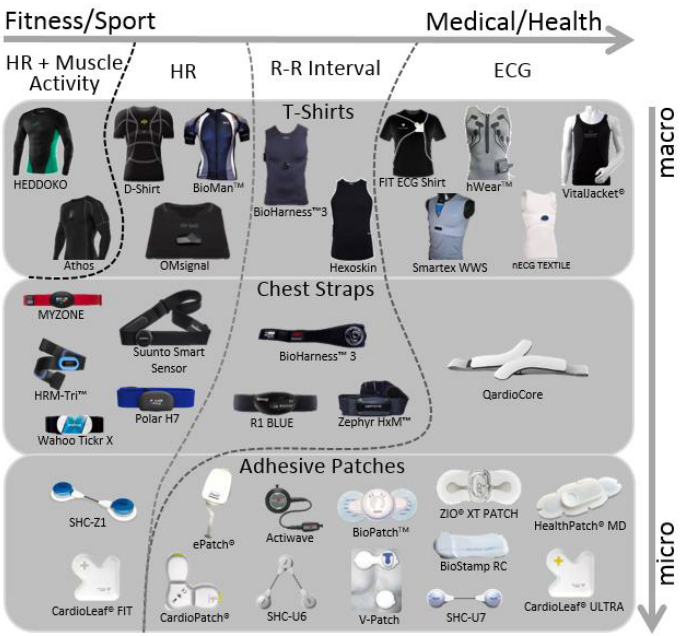
Figure 5. Heart activity trackers divided by type of WHD on the body (t-shirt, chest strap or